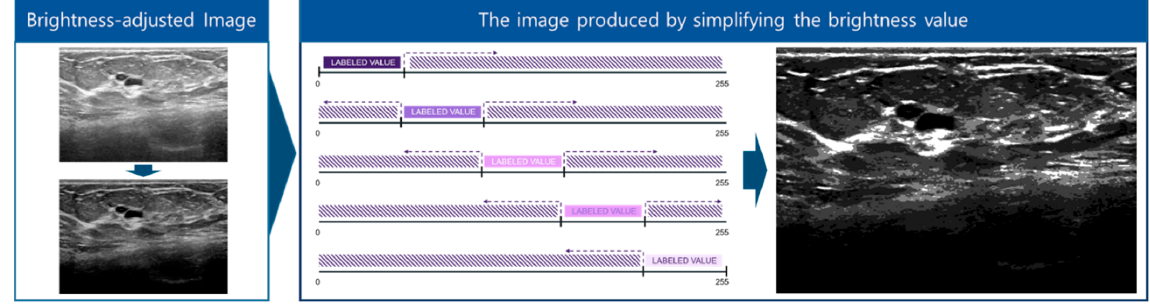
Figure 6. The image produced by simplifying the brightness value.